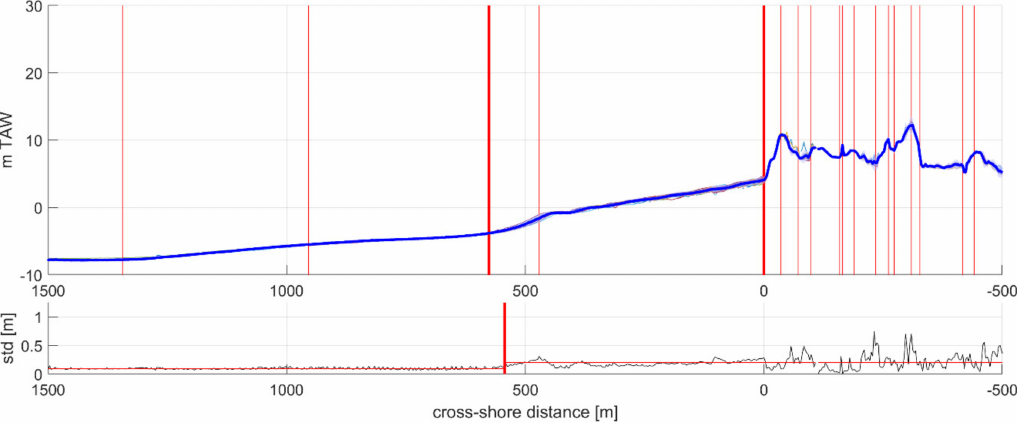
Figure 3. Investigation of profile dynamics using ± yearly topobathymetric monitoring data. Example of a profile illustrating the method used. In the upper panel the location of the changepoints in the slope are shown by vertical red lines. In the lower panel the variation of the standard deviation is shown with the horizontal red lines indicating average values for the zones seaward and landward of a changepoint (vertical red